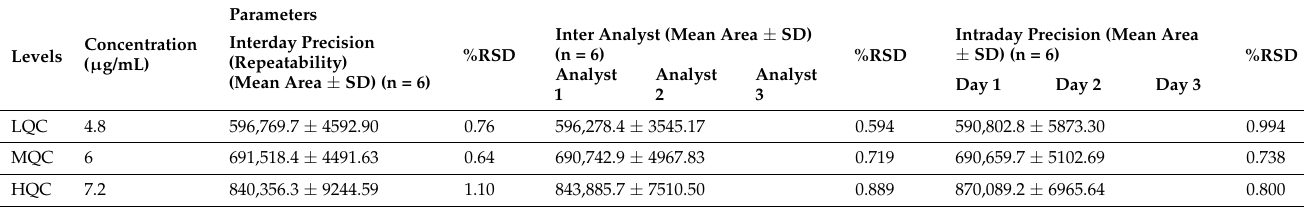
Table 5. Represented precision